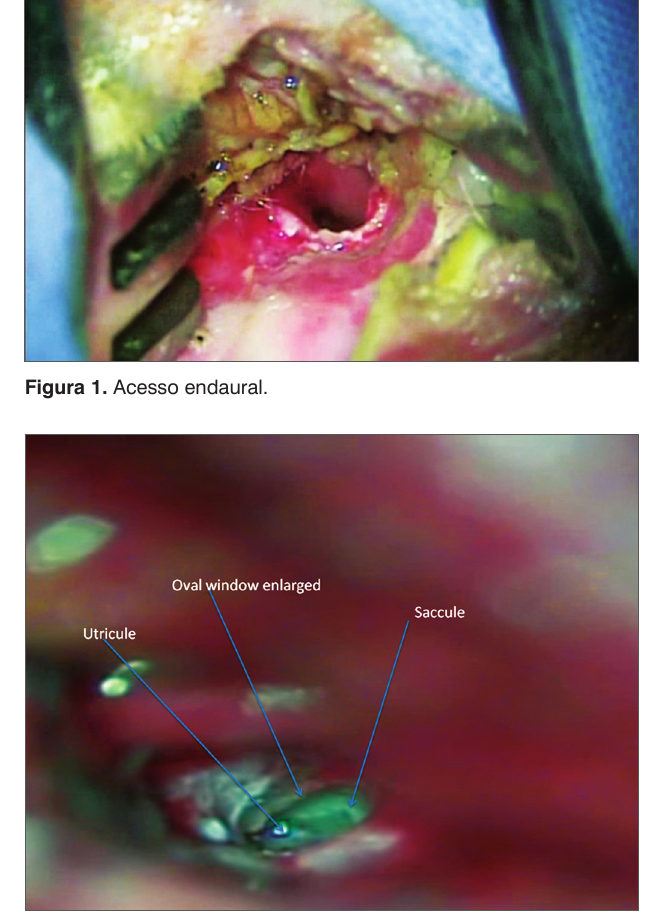
Figura 2. Janela oval ampliada, utrículo e